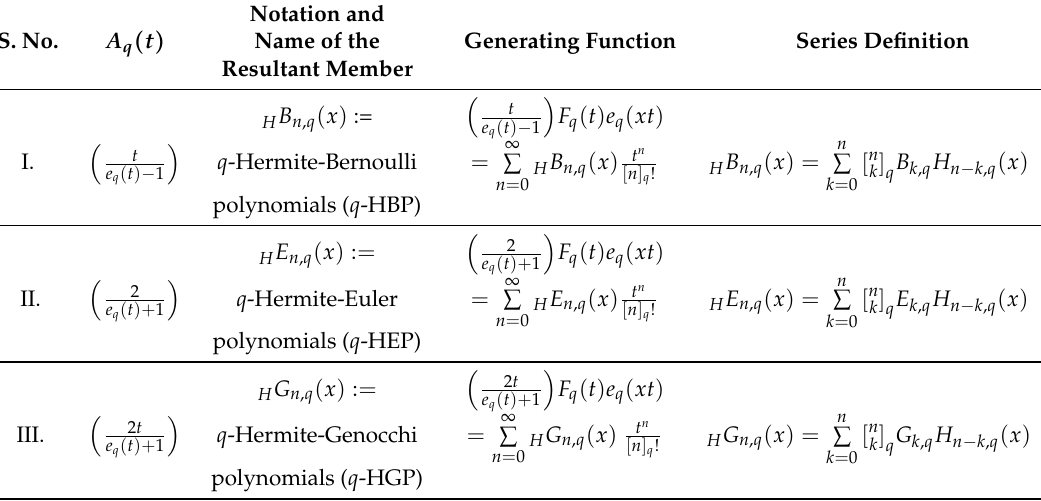
Table 3. Members related to q -Hermite-Appell